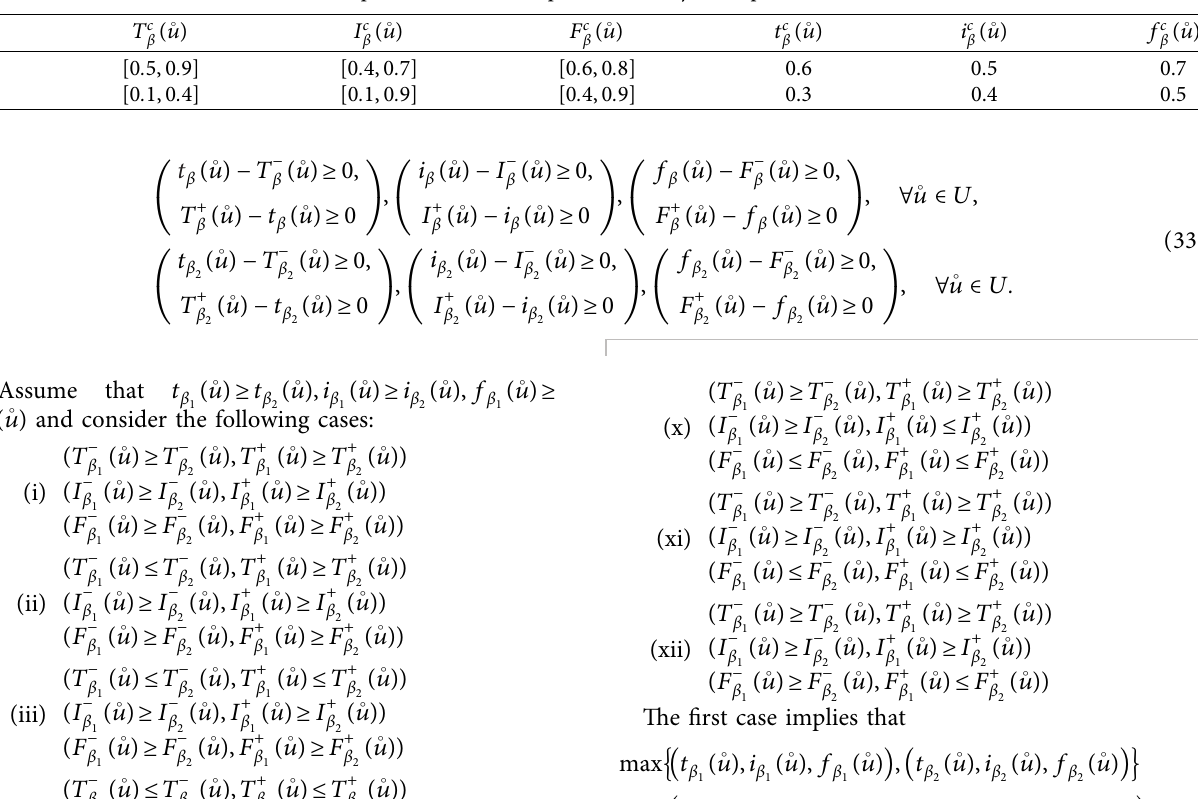
Table 9: Complement of neutrosophic cubic set β of U provided in Table